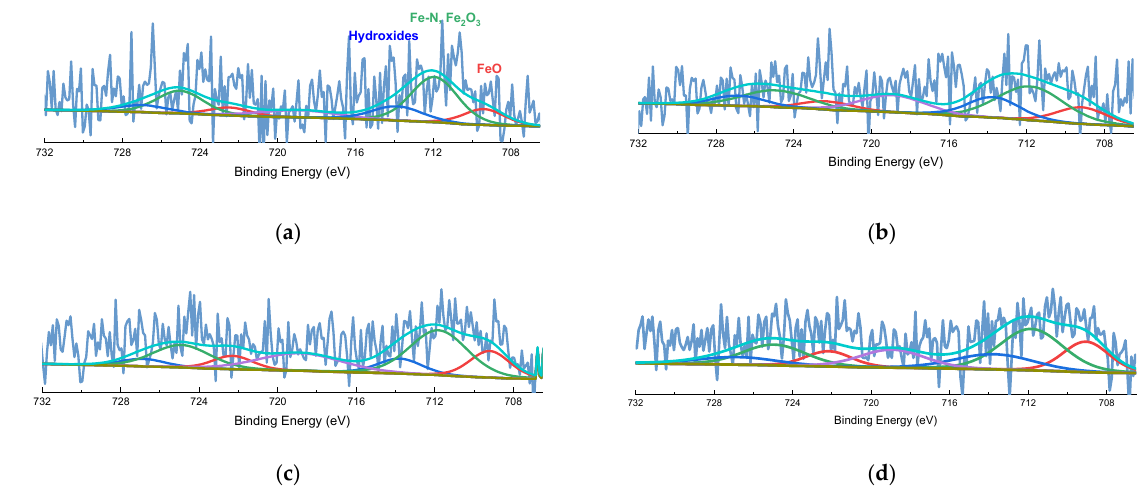
Figure 6. Fe 2p spectra of ( a ) Fe-N-C, ( b ) Fe-N-C_PA-0.066, ( c ) Fe-N-C_PA-0.100, and ( d ) Fe-N-C_PA-0.135.